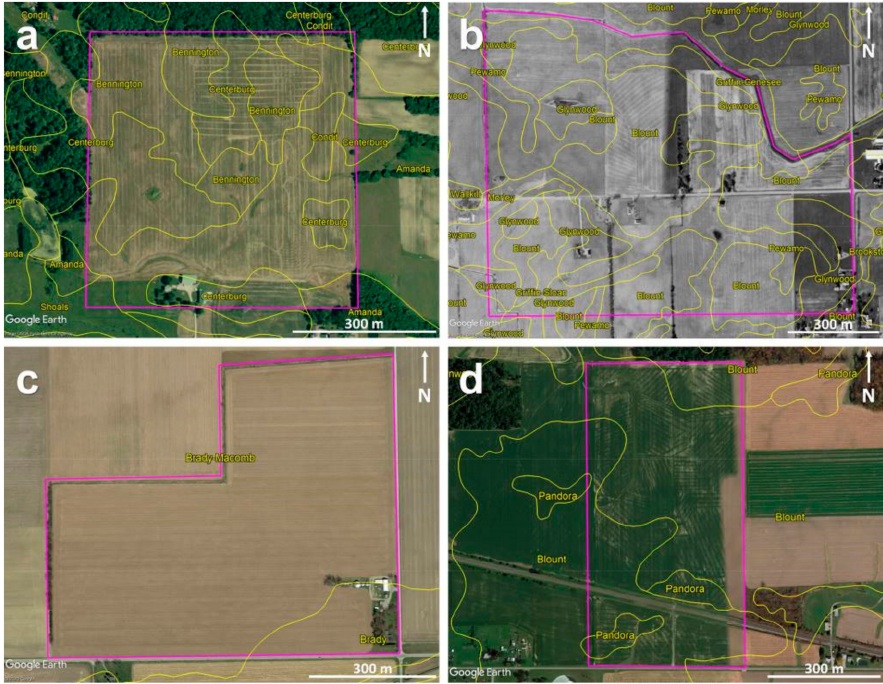
Figure 2. Google Earth aerial images of the agricultural sites under investigation overlaid with soil maps (in yellow) from SoilWeb-Earth: ( a ) Site-1, ( b ) Site-2, ( c ) Site-3, and ( d ) Site-4. Purple lines mark the site